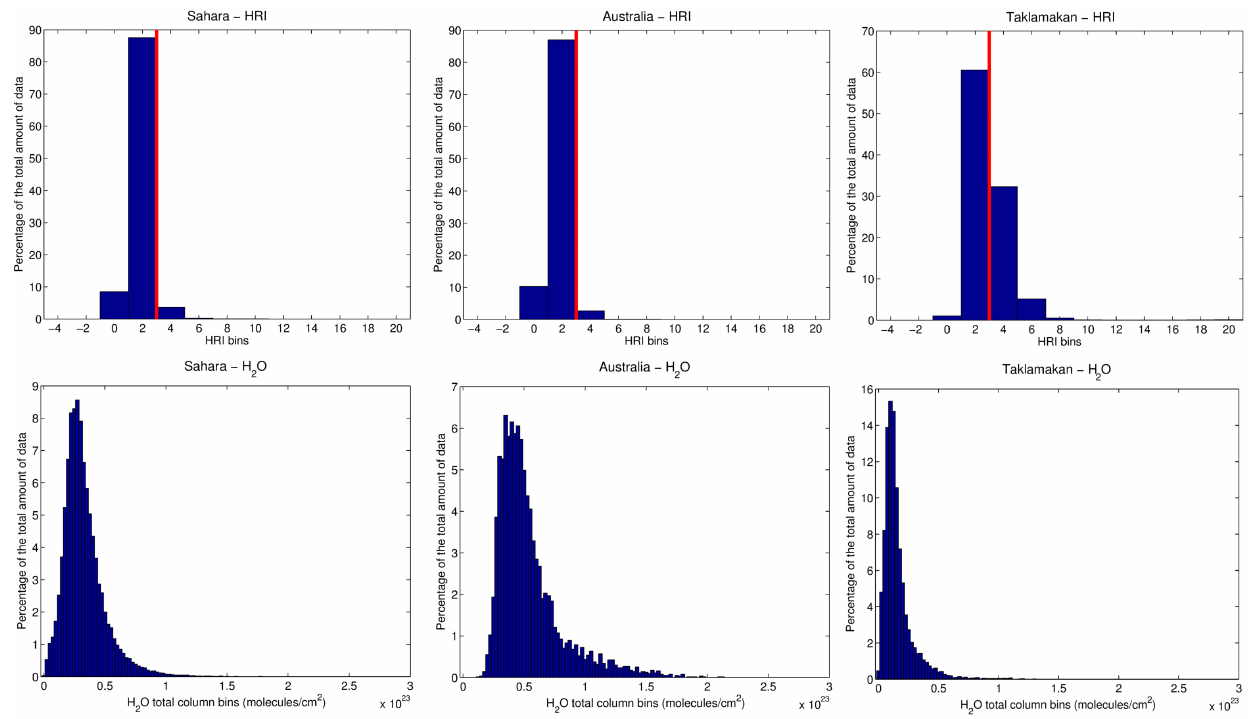
Figure 7. Distributions of IASI measurements (expressed in % of the total amount of data considered) as a function of HRI values (top panels) and the total column of H 2 O (bottom panels) over the Sahara (left panels), the centre of Australia (middle panels) and Taklamakan (right panels). IASI observations for the period 2011–2014 and located in the areas 18–27 ◦ N/6 ◦ O–28 ◦ E, 29–21 ◦ S/121–140 ◦ E and 36– 40 ◦ N/78–86 ◦ E have been respectively considered for the Sahara, the centre of Australia and Taklamakan. Only those with less than 20% cloud coverage and with available L2 temperature and H 2 O profiles and surface temperature have been selected. No filter using the error on the retrieved SO 2 column has been applied. The red lines in the top panels indicate the detection limit (see Sect.